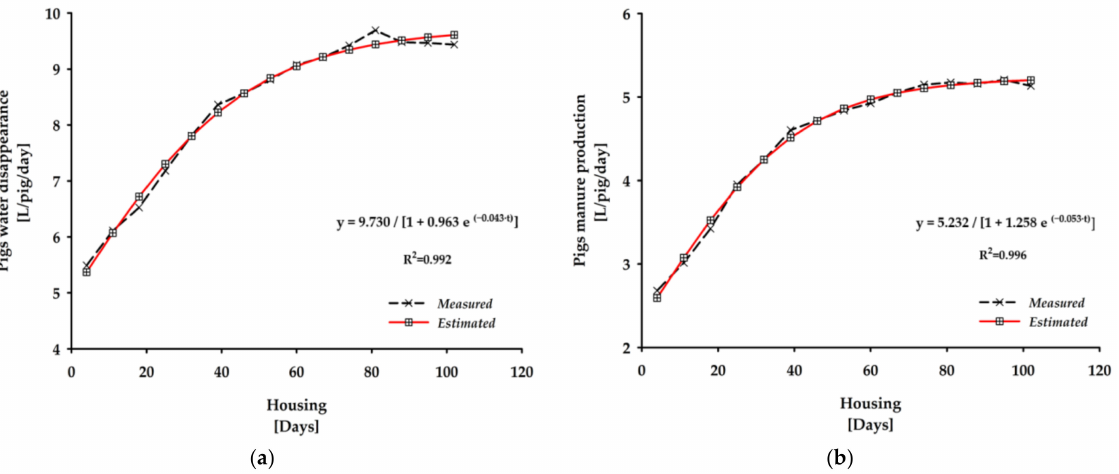
Figure 3. Adjustment of the non-linear Logistic model to the weekly means data considering the pigs’ body weight for the growing–finishing phase: ( a ) Water disappearance; ( b ) Manure production.